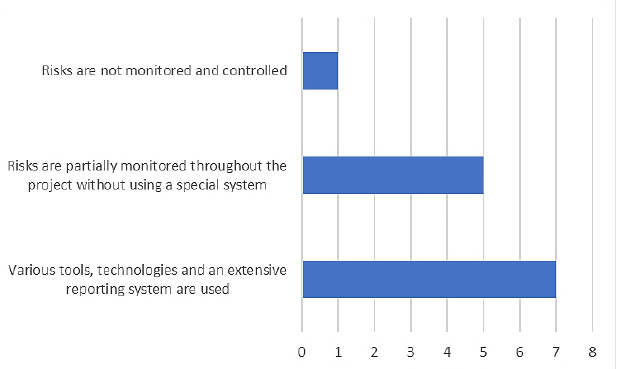
Fig. 6. Risk monitoring in the surveyed